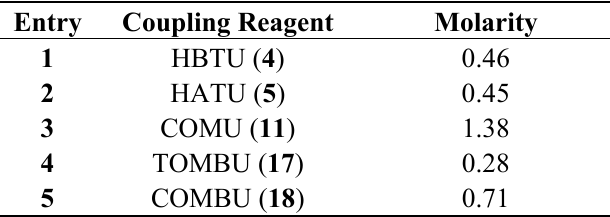
Table 1. Molar solubility of uronium/aminium-type coupling reagents in DMF.